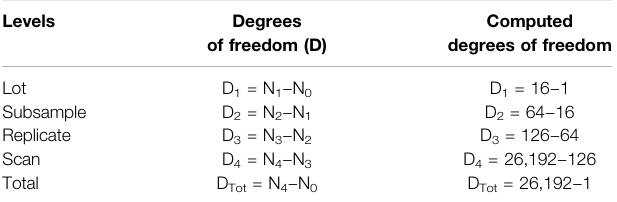
TABLE 1 | The degree of freedom computation for the nested ANOVA. N 4 is the total number of scans. Levels Degrees of freedom (D)